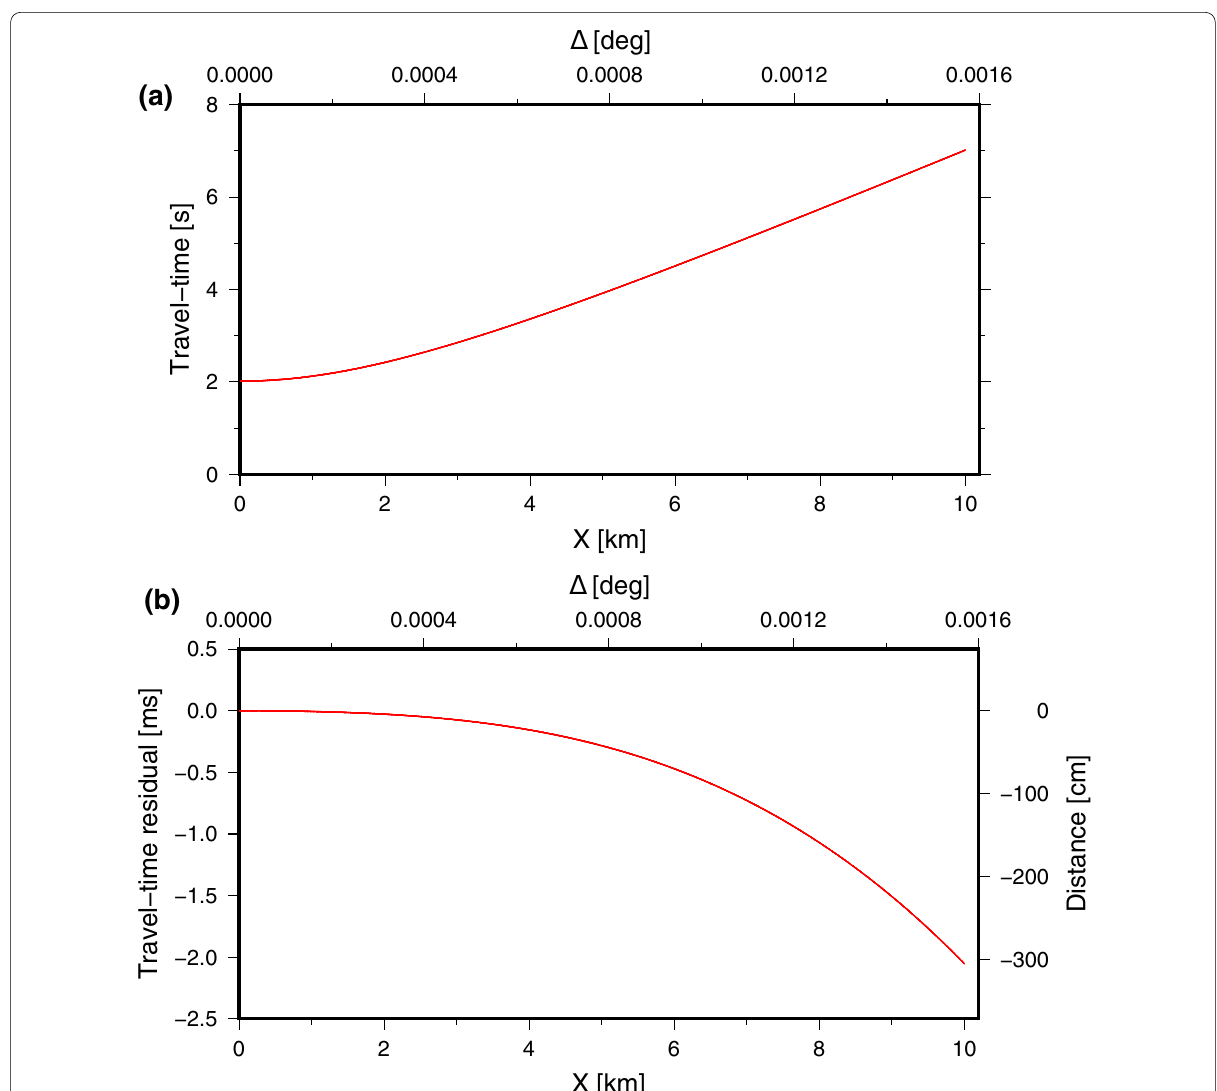
Fig. 2 Travel-times of the simulation data. a Simulated exact travel times. b Travel-time residuals that rough spherical travel times are subtracted from the exact